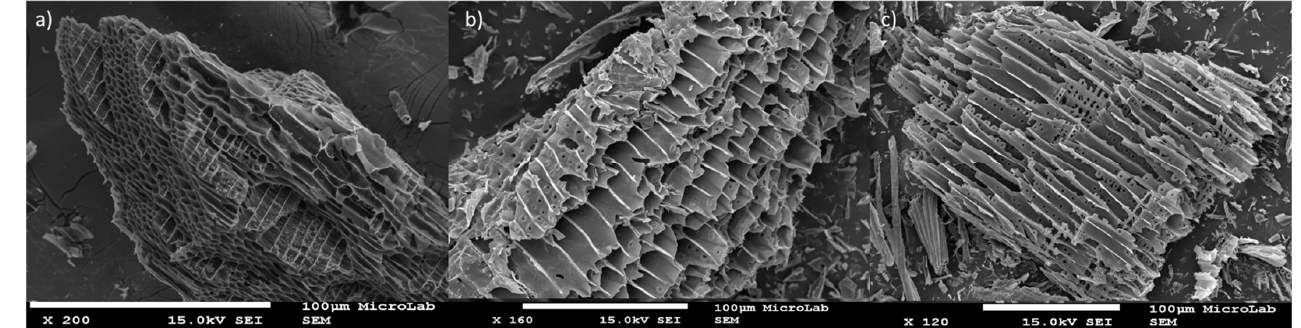
Figure 11. SEM images for ( a ) PS-Raw; ( b ) PS-C600; ( c ) PS-AC (resolution of 100 μ m).